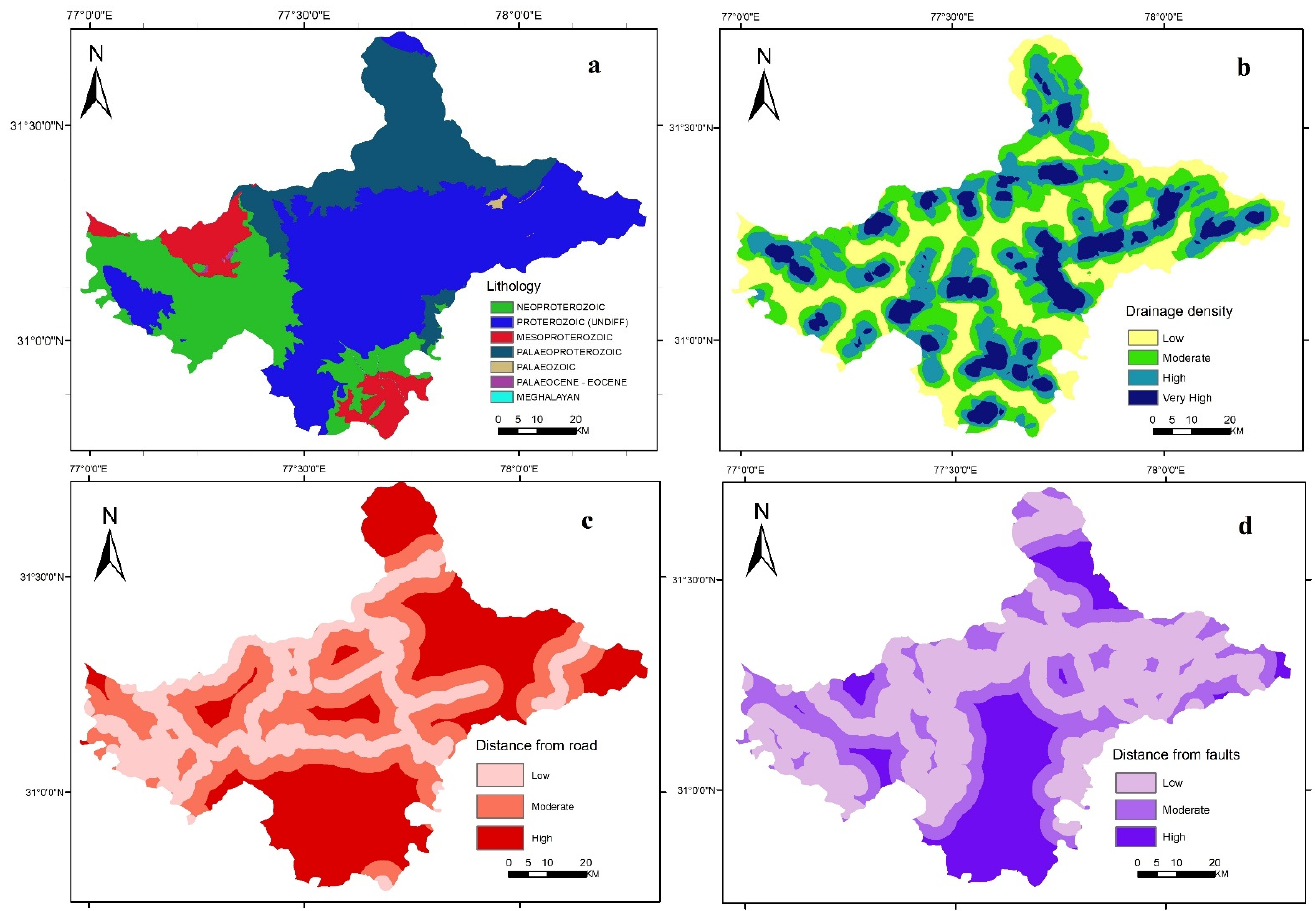
Figure 3. Causative factors: ( a ) Lithology ( b ) Drainage density ( c ) Distance from road ( d ) Distance from